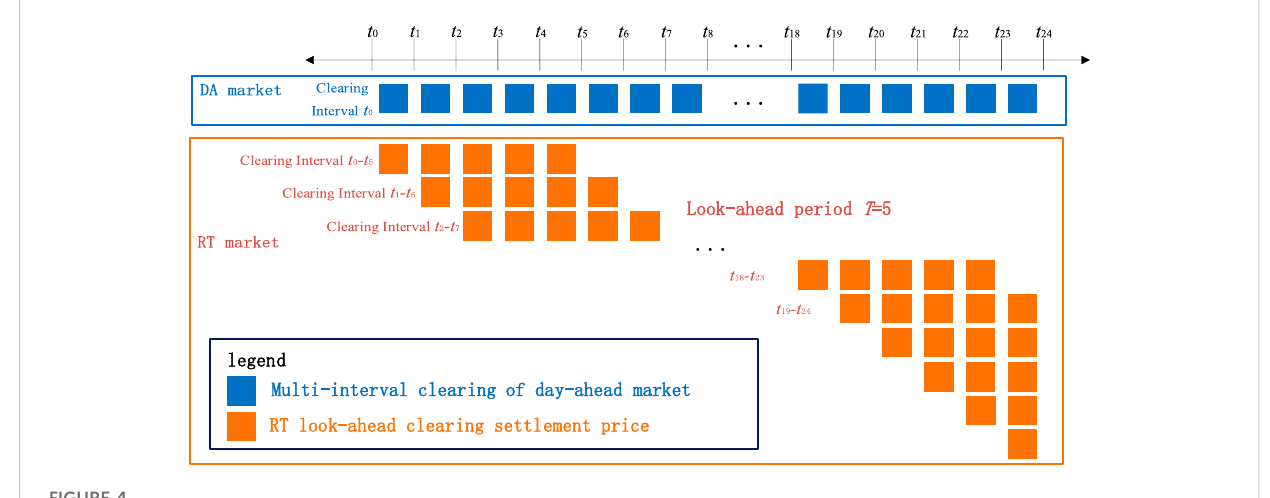
FIGURE 4 Look-ahead multi-interval